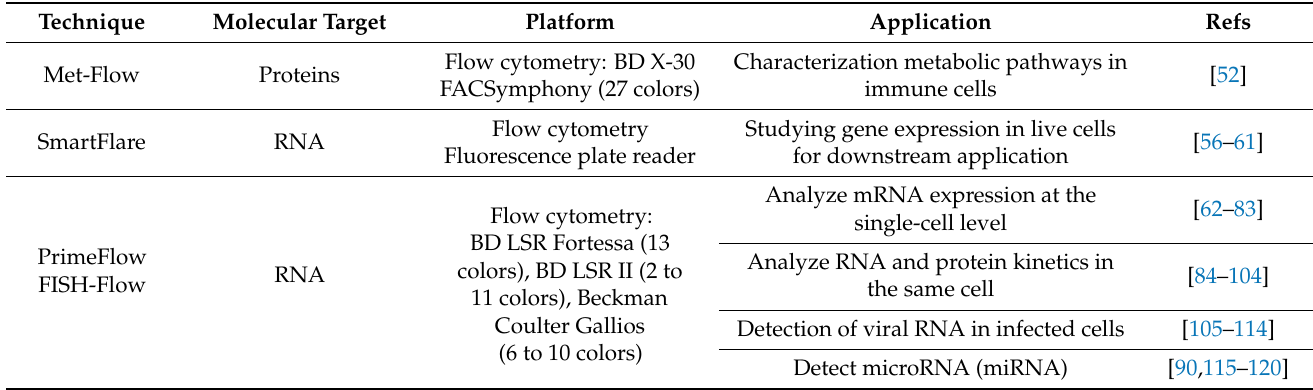
Table 1. RNA and protein analysis by flow